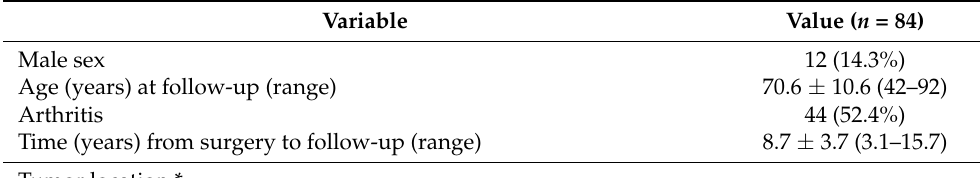
Table 1. Characteristics of the spinal meningioma